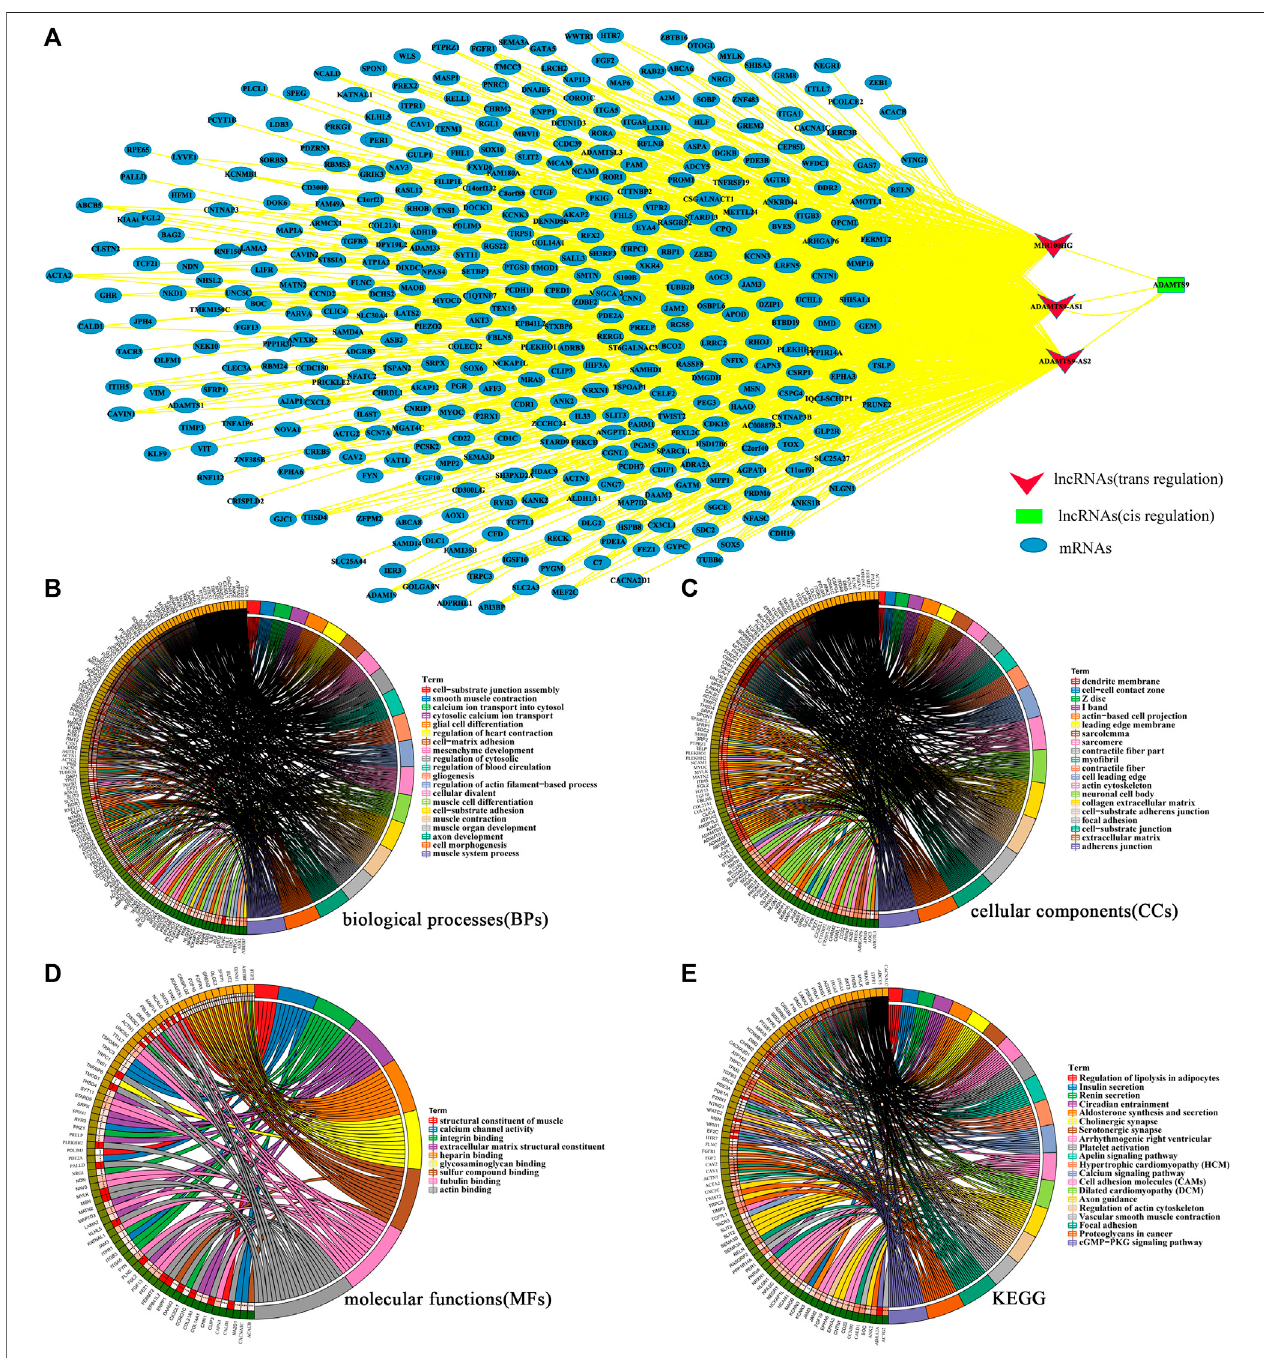
FIGURE4|(A) .ThelncRNA-mRNAcoexpressionnetworkofkeylncRNAsandkeymRNAs.Theredinvaginatedtrianglerepresents trans -regulatedlncRNAs.The green squares represent cis regulated lncRNAs. The blue oval represents mRNAs. (There were two different regulation modes for the co expression of lncRNA and mRNA.Onewascisregulation.Inthisregulationmode,lncRNAonlyactswithmRNAswithin10 kbupstreamanddownstream,andtheirexpressionwascorrelated.The other wastrans regulation, which was aimed at mRNAsthat are notwithinthe distancerange but have correlation in expression.) (B,C,D,E) Functional enrichment analysis of mRNAs in the lncRNA-mRNA coexpression network. The possible biological processes (B) , cell components (C) , molecular functions (D) and signal pathways (E) were analyzed. The circle diagram consists of two parts, the left half represents the mRNAs analyzed, and the right half represents the biological functions enriched by mRNAs. p -value of < 0.05 and False Discovery Rates (FDR) < 0.25 were considered statistically signi fi cant.